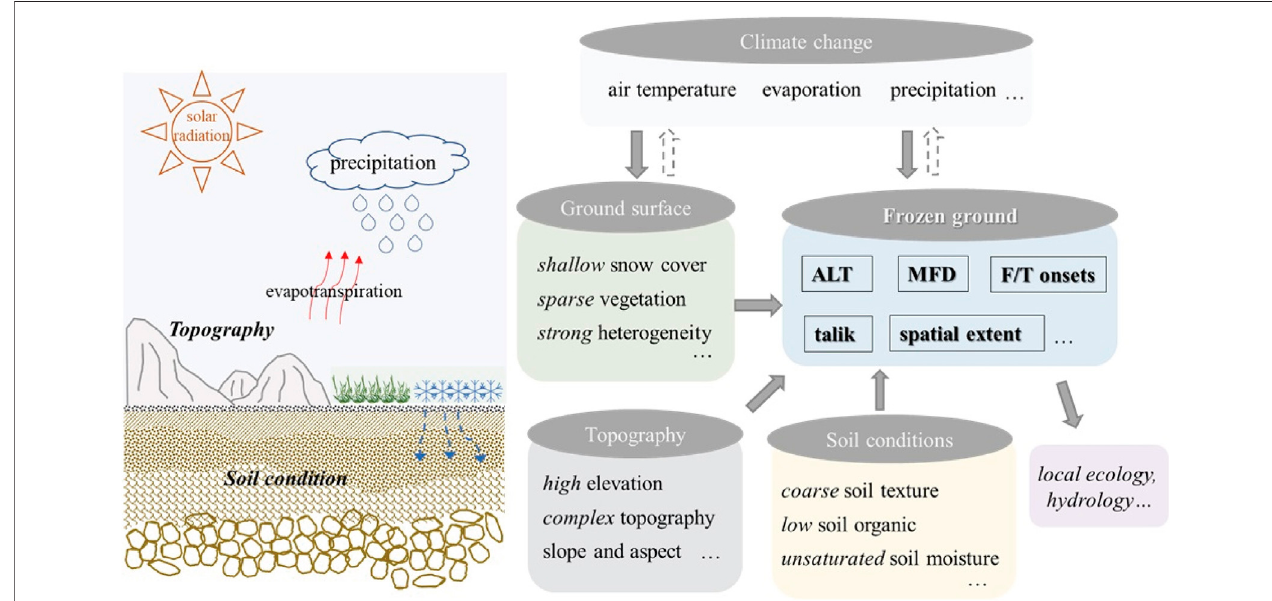
FIGURE2| Interaction amongdifferentenvironmentalfactors andsoilfreeze/thaw (F/T)dynamicsintheTibetanPlateauregion.Solidand dasharrows indicate the in fl uences and feedbacks respectively. ALT and MFD represent active layer thickness (de fi ned for permafrost area) and maximum frozen depth (de fi ned for seasonally frozen ground)